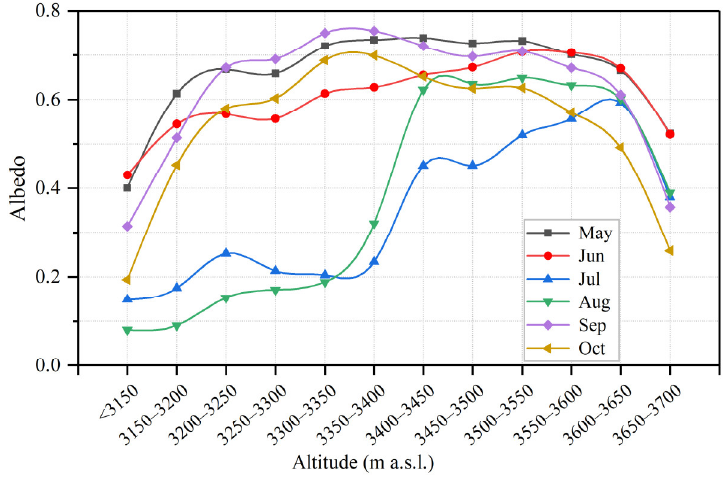
Figure 4. Variability in surface albedo along the glacier main flowline.